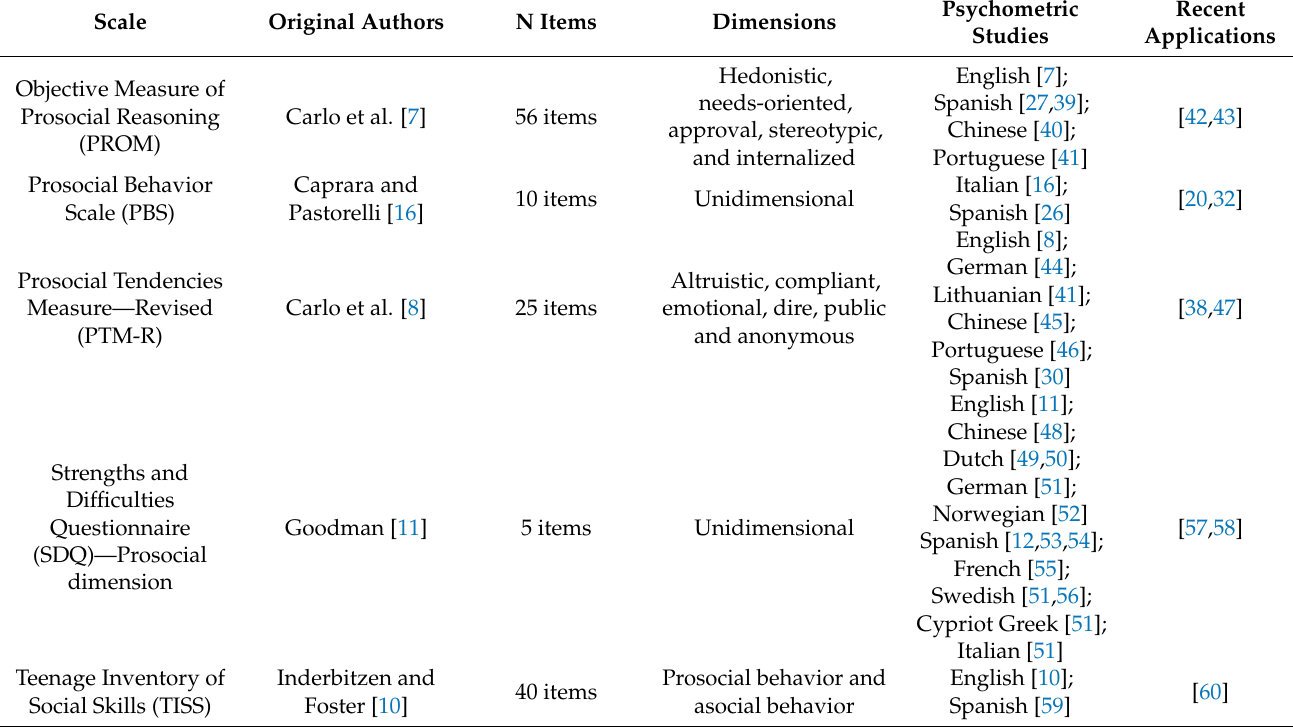
Table 1. Instruments for assessing prosocial behavior in